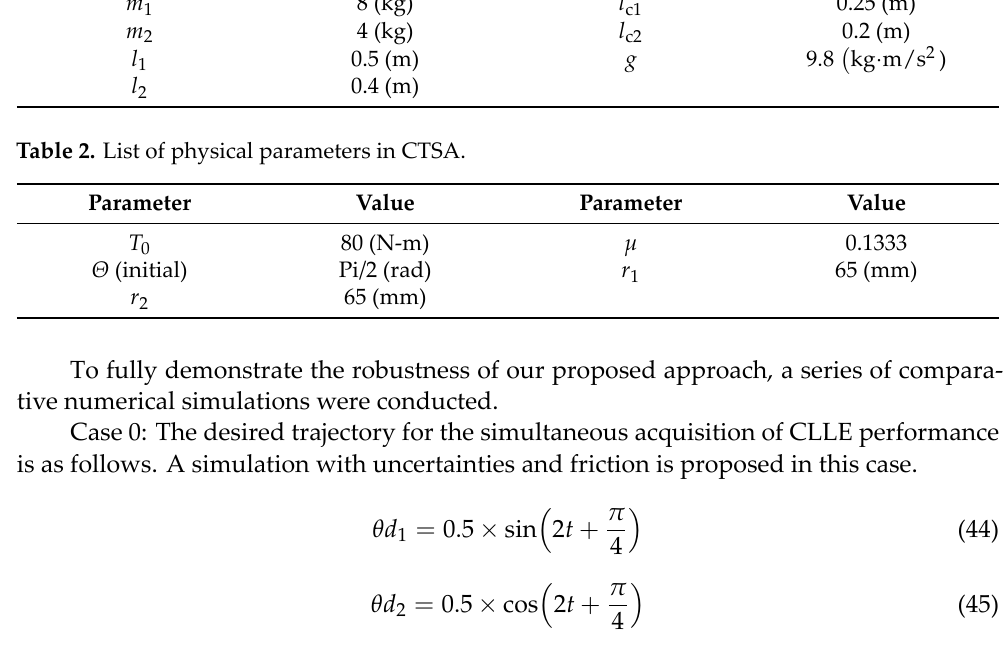
Table 1. List of physical parameters in 2‑DOF lower limb exoskeleton. Parameter